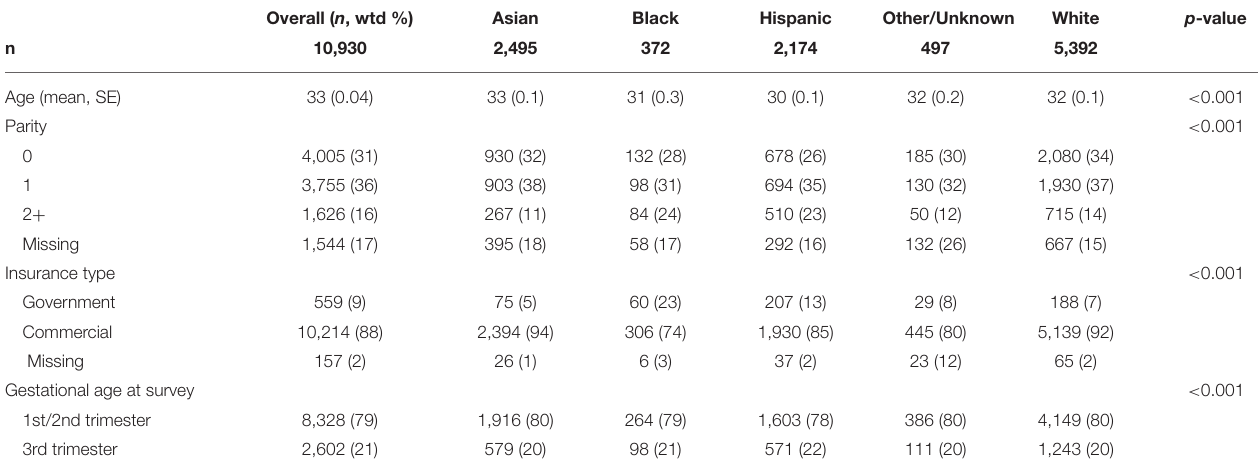
TABLE 1 | Demographic characteristics overall and by racial and ethnic category of 10,930 pregnant people seeking prenatal care at Kaiser Permanente Northern California during the COVID-19 pandemic between June 2020 and April 2021.